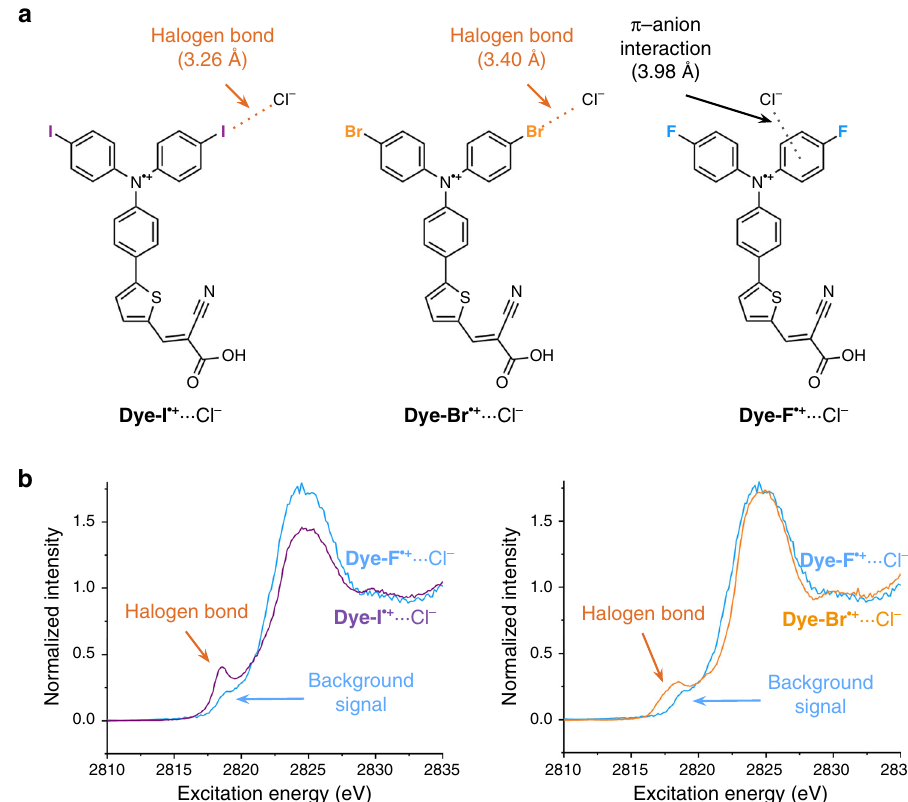
Fig. 2 Predicted adduct structures and experimental XAS spectra. a The Dye-X (cid:129) + ···Cl − adduct structures predicted by DFT methods. b The experimental XAS spectra of the Dye-I (cid:129) + ···Cl − halogen bonded dimer (purple line) and the Dye-Br (cid:129) + ···Cl − halogen bonded dimer (orange line) overlaid with the non- halogen bonding Dye-F (cid:129) + ···Cl − control (blue line) 37 halogen bonds 41,42 . For the halogen bonded chloride adducts of Dye-I (cid:129) + and Dye-Br (cid:129) + , we fi nd that the well-resolved low-energy “ pre-edge ” spectral signature arises from π -orbital covalency.